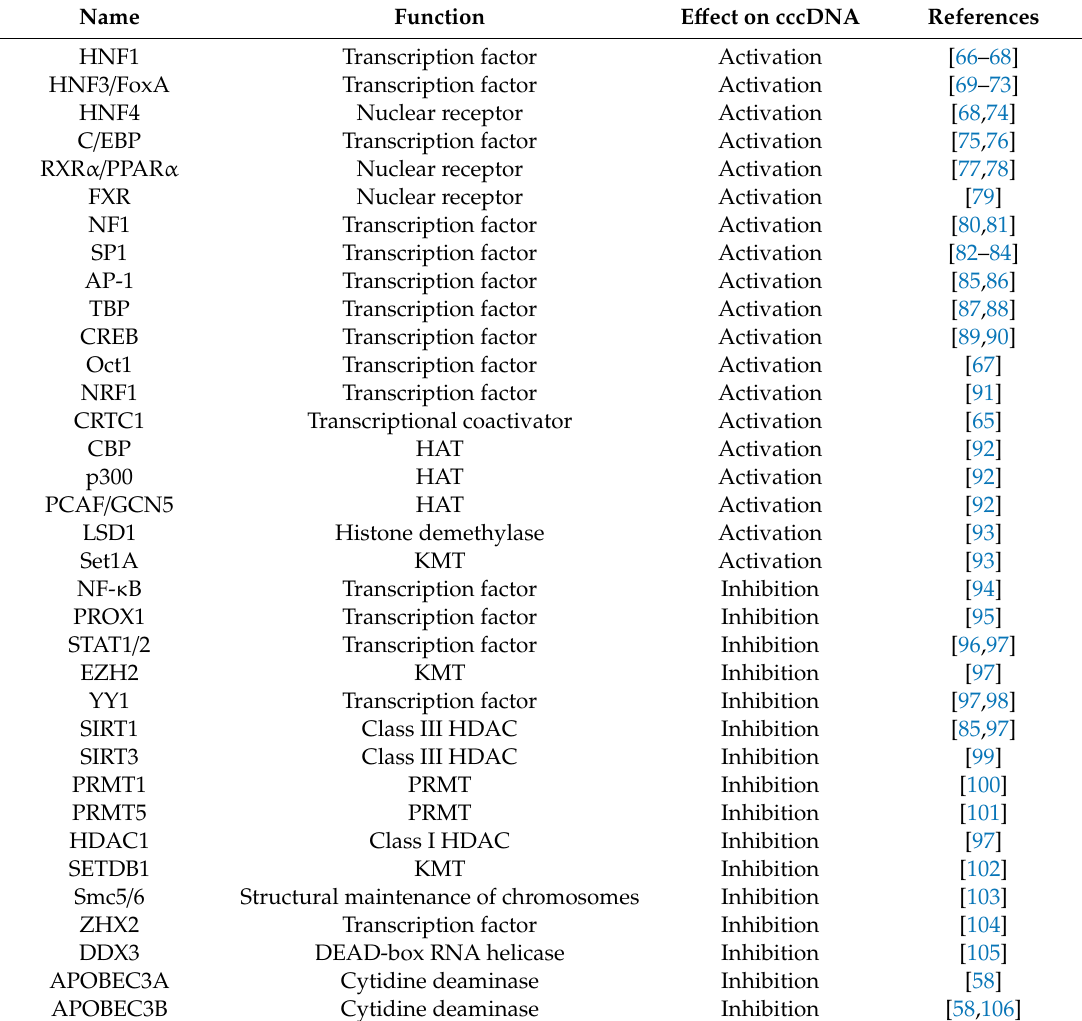
Table 1. Host factors that promote or repress HBV cccDNA